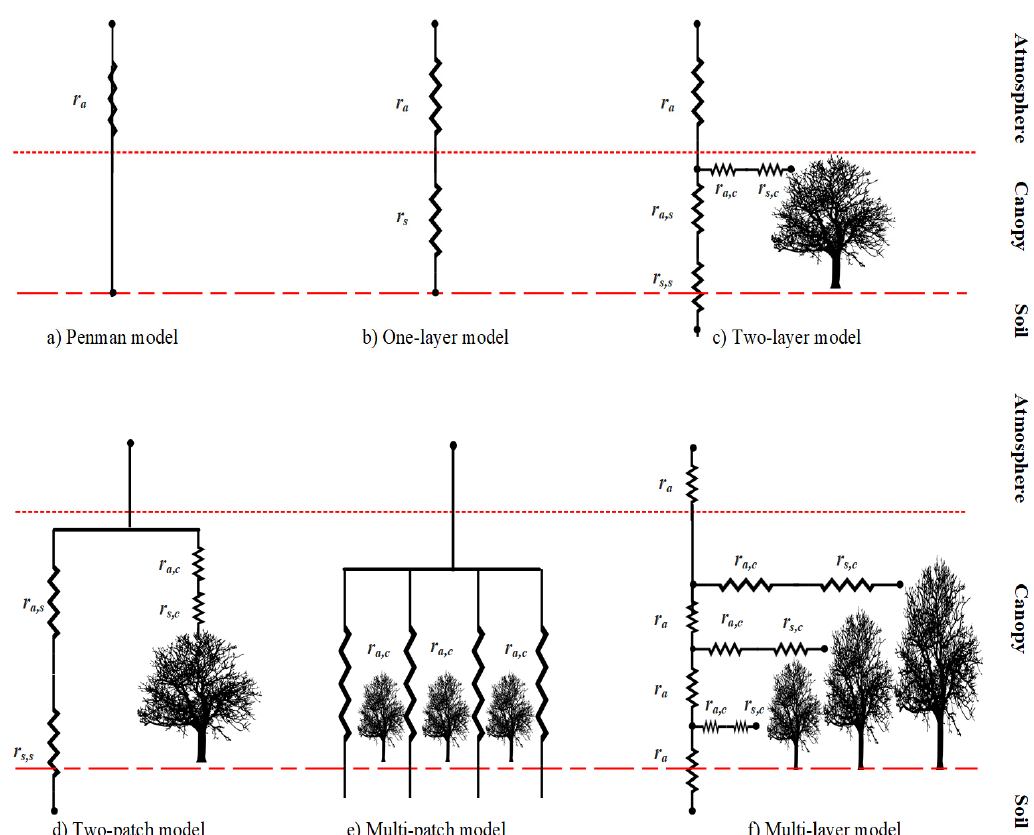
Figure 2. Schematic diagrams of different PM-based models (r a = aerodynamic resistance (s/m); r s = surface resistance (s/m), r a,c = aerodynamic resistance for the canopy component (s/m); r a,s = aerodynamic resistance for the soil component (s/m); r s,c = surface resistance for the canopy component (s/m); r s,s = surface resistance for the soil component (s/m)).